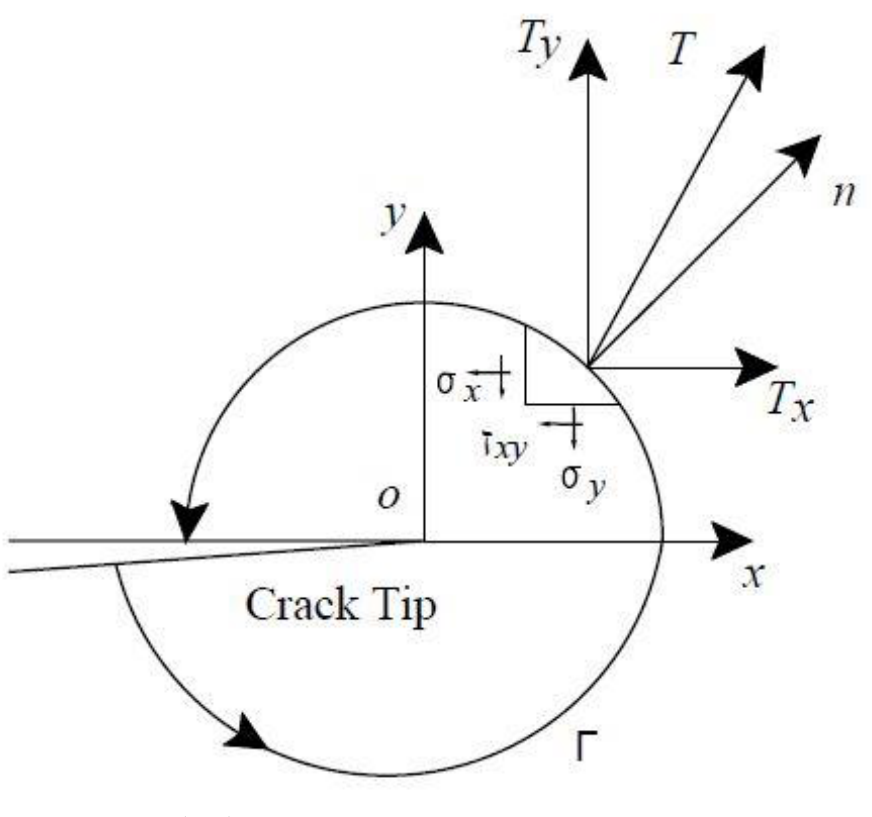
Figure 1. J-integral path.